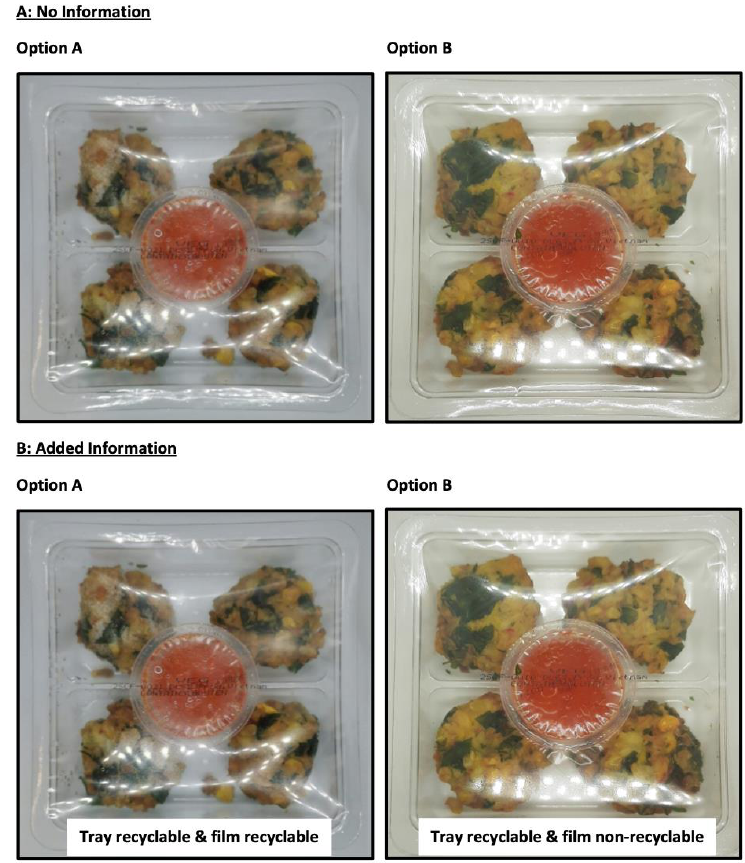
Figure 2. Summary of the two food packages. This question was asked twice: ( A ) with no information and ( B ) with added information, using a three-point category scale (option A, option B and no preference) to understand if consumers’ response was modulated by the additional